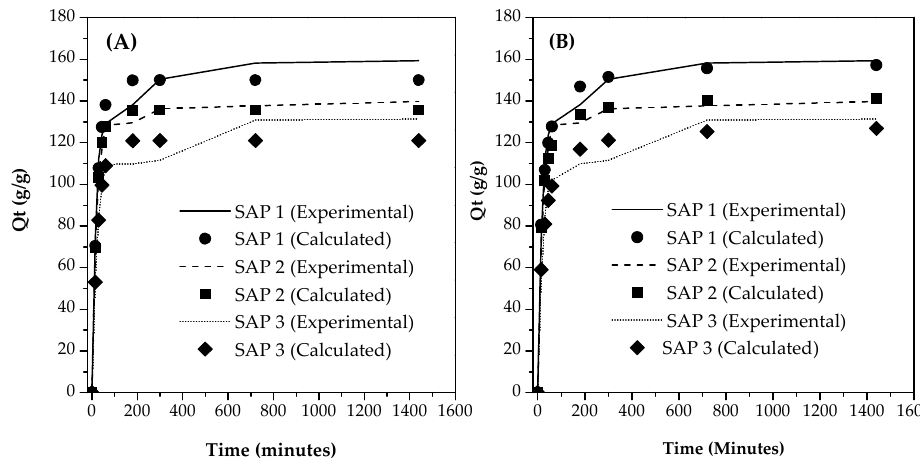
Figure 4. Comparison between experimental data and calculated data from the swelling kinetics model for ( A ) pseudo ‐ first ‐ order and ( B ) pseudo ‐ second ‐ order models.